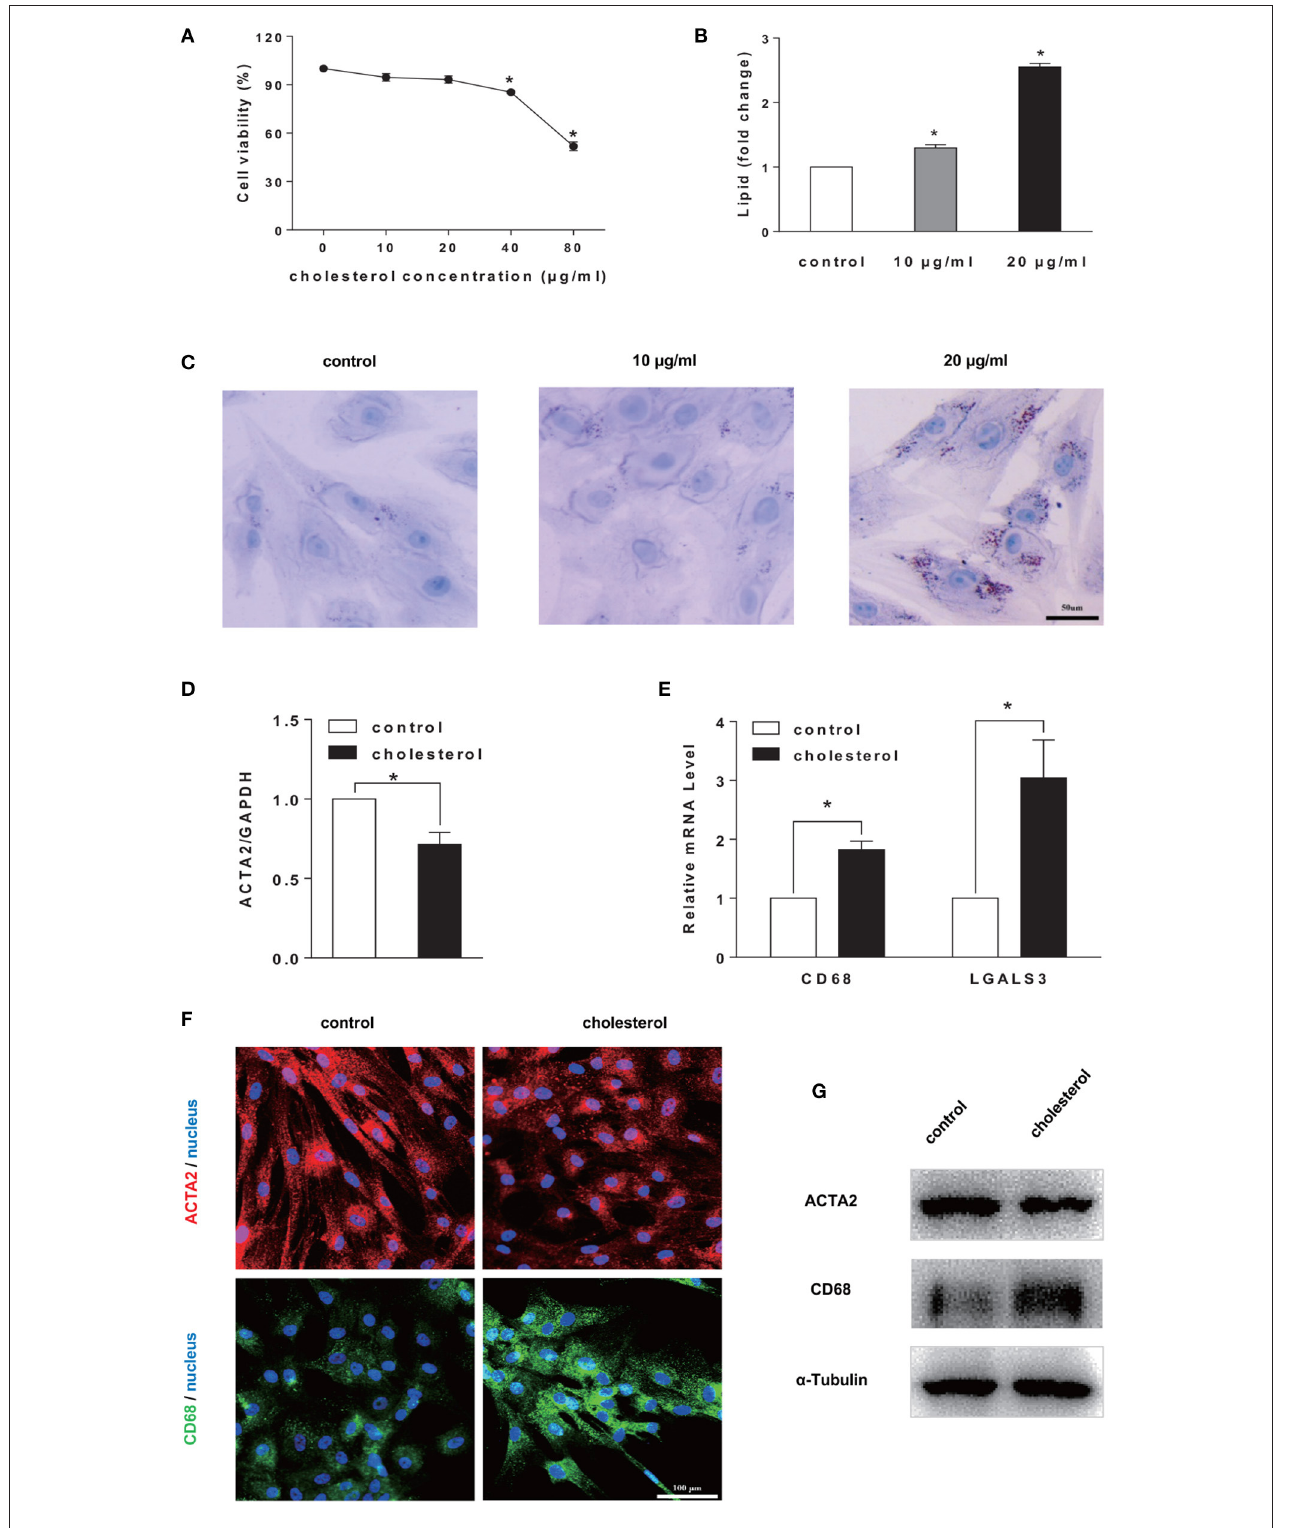
FIGURE 1 | Cholesterol accumulation induced SMCs phenotype switching to a foam cell-like state. (A) Cell viability test. SMCs were treated by Chol: M β CD at different concentrations for 72 h. CCK-8 was used to determine cell viability ( n = 3). (B,C) Cellular cholesterol amount determination. Oil Red O staining (in C ) (scale